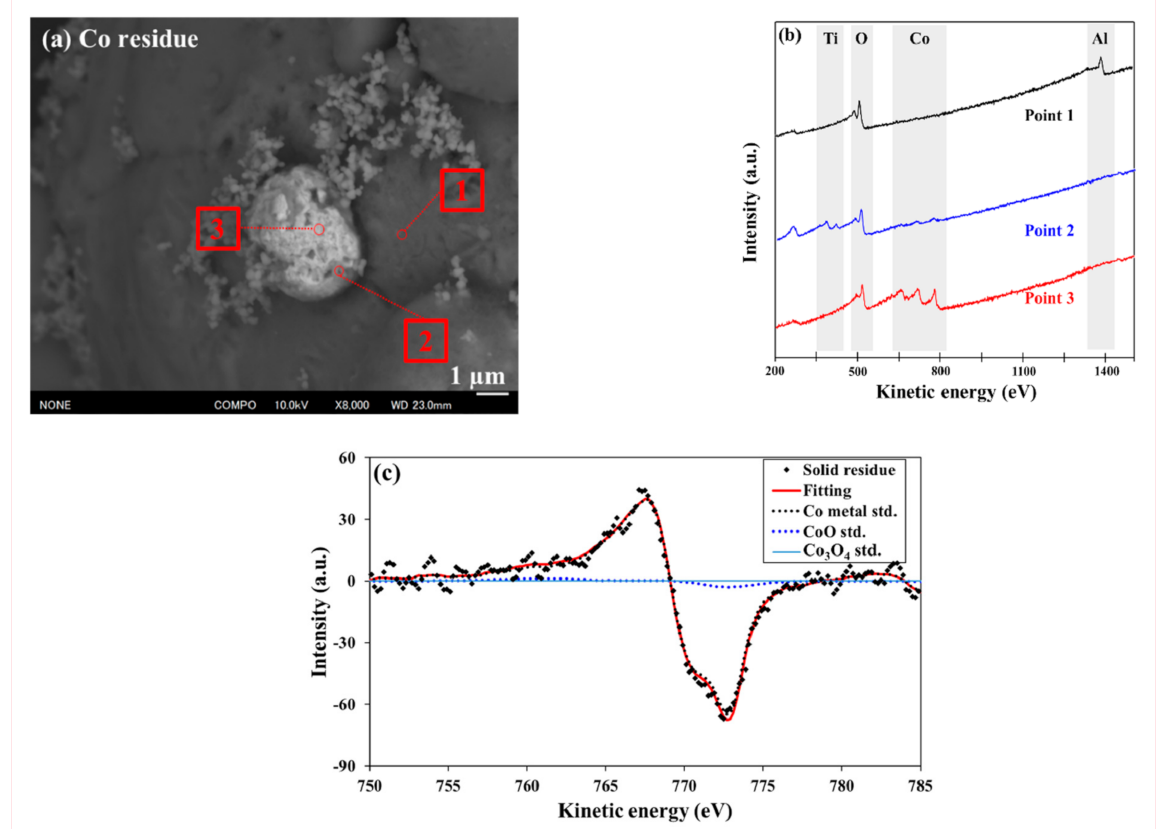
Figure 6. Auger electron spectroscopy (AES) results of the residue obtained after cementation of Co 2+ from chloride solution using TiO 2 /Al: ( a ) photomicrograph, ( b ) wide scan energy spectrum of each point, and ( c ) the narrow scan energy spectrum of the Co peak with fitting spectra of Co, CoO, and Co 3 O 4